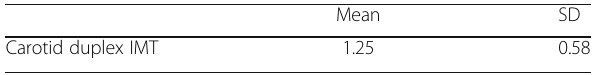
Table 1 Age and gender of patients recruited in this study Gender